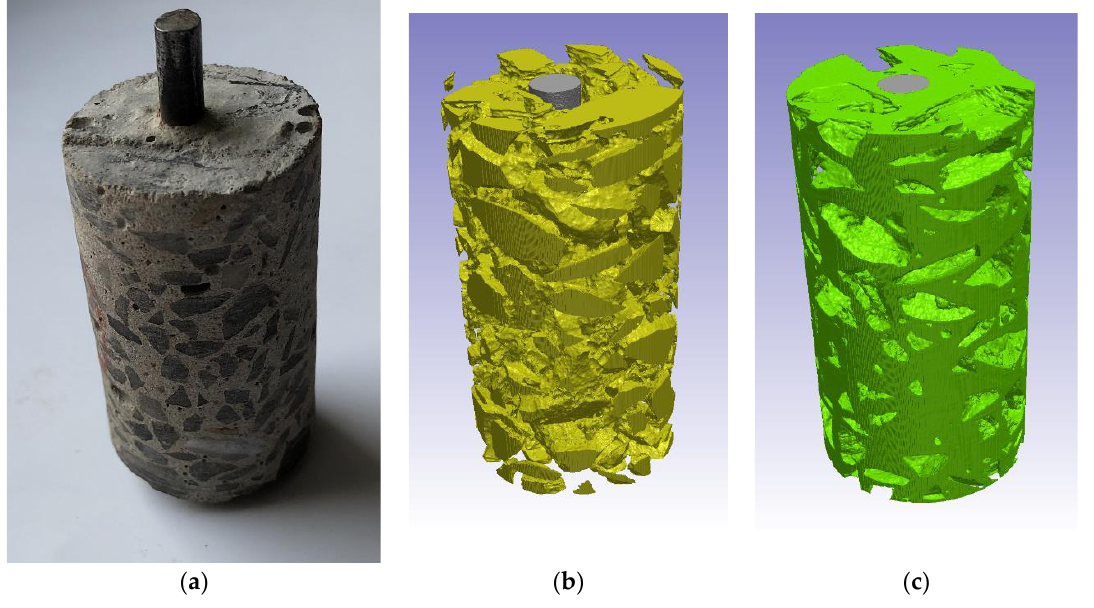
Figure 1. A photograph of the concrete sample for which simulations were performed ( a ). Computed tomography reconstruction of: ( b ) aggregates in the sample — yellow color, and ( c ) mortar — green color. The steel rod is shown in gray.